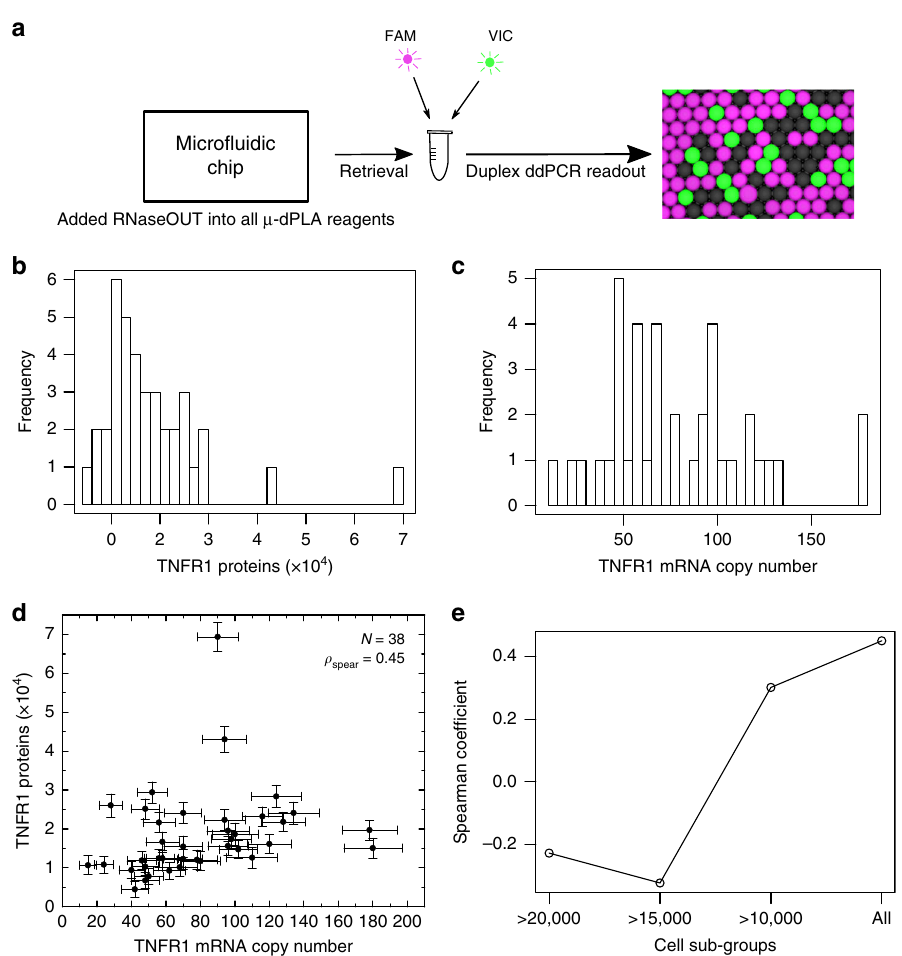
Fig. 3 Joint digital protein/messenger RNAs (mRNAs) quanti fi cation in single cells. a Work fl ow of the duplex protein – mRNAs reaction. TaqMan probes with FAM and VIC fl uorophore were used for joint quanti fi cation of protein and mRNA, respectively. b Histogram of TNFR1 protein counts in single human lung epithelial cells (H1299) cells. c Histogram of TNFR1 mRNA counts in the same single H1299 cells. d Joint TNFR1 mRNA and protein copy numbers in single cells is shown. See Methods for calculation of error bars. Thirty-eight single cells were measured ( N ), and the Spearman ’ s correlation coef fi cient between mRNA and protein counts is 0.45 ( ρ ). e The calculated Spearman ’ s coef fi cient reduces signi fi cantly if we exclude the cells that express TNFR1 at very low levels. The X -axis shows the threshold for exclusion, for example, >20,000 indicates that only cells with more than 20,000 TNFR1 protein copies are included in the calculation. Error bars calculation is mentioned in the Methods